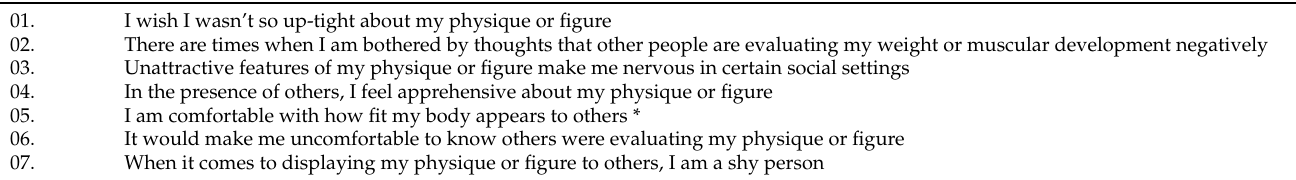
Table A2. List of items in the original English version of SPAS-7. 01.